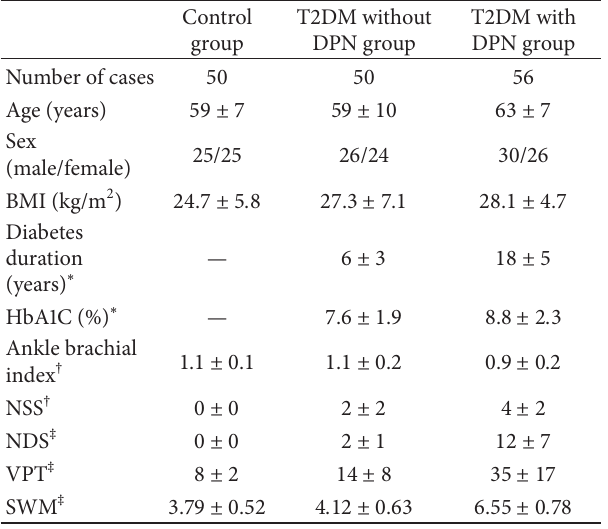
Table 1: Characteristics of the study